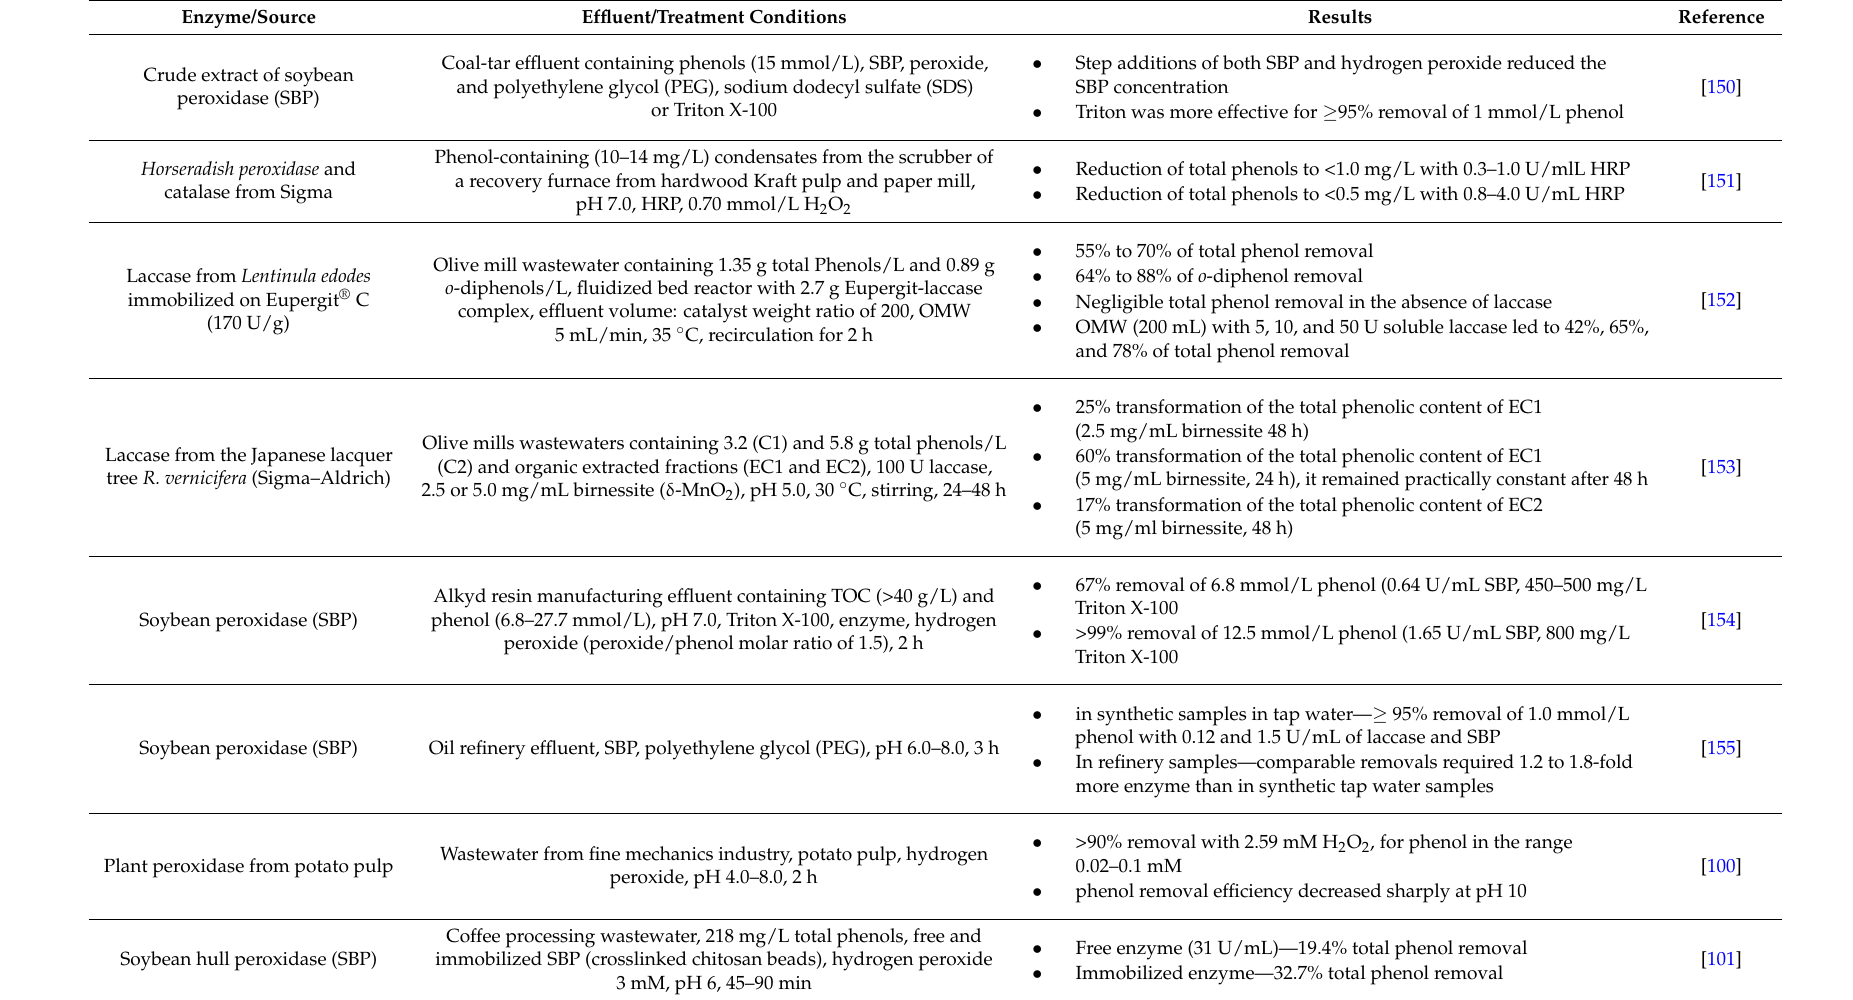
Table 4. Removal of phenolic compounds from industrial effluents by biocatalysts of different biological sources. Enzyme/Source Effluent/Treatment Conditions Results